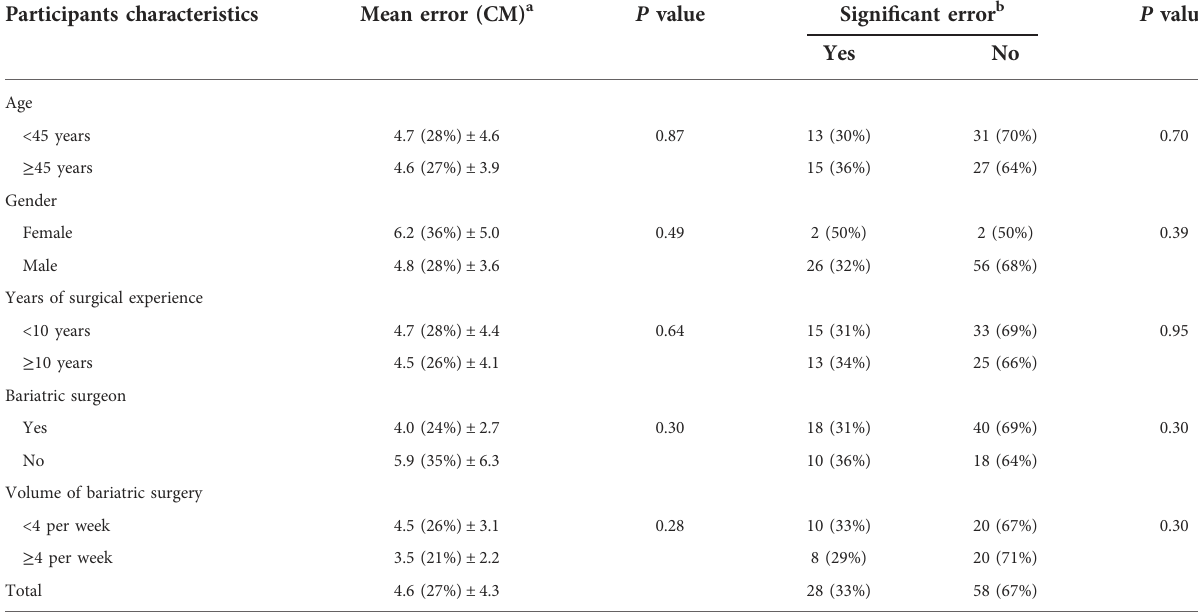
TABLE 2 Relationship between different participants ’ characteristics and error of bowel length estimation.